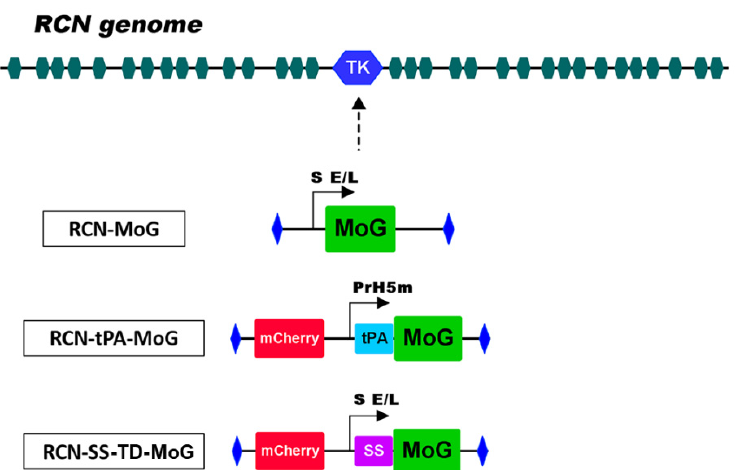
Figure 1. A map of the RCN genome showing insertion of recombinant cassettes at the tk site. The RCN-MoG cassette contains the mosaic glycoprotein ( MoG ) gene under the control of the S E/L promotor. The RCN-tPA-MoG cassette map contains the mCherry fluorescent marker, the tissue plasminogen activator ( tPA ) secretory signal under the control of the PrH5m promoter, and the MoG gene. The SS-TD-MoG cassette contains the mCherry fluorescent marker, the human IgG secretory signal ( SS ) under the control of the S E/L promoter, and the MoG gene with the CVS-11 transmembrane domain sequence. The secretory signals ( tPA and SS ) and promoters ( S E/L and PrH5m ) were added to their respective cassettes to enhance expression and extracellular secretion of MoG.